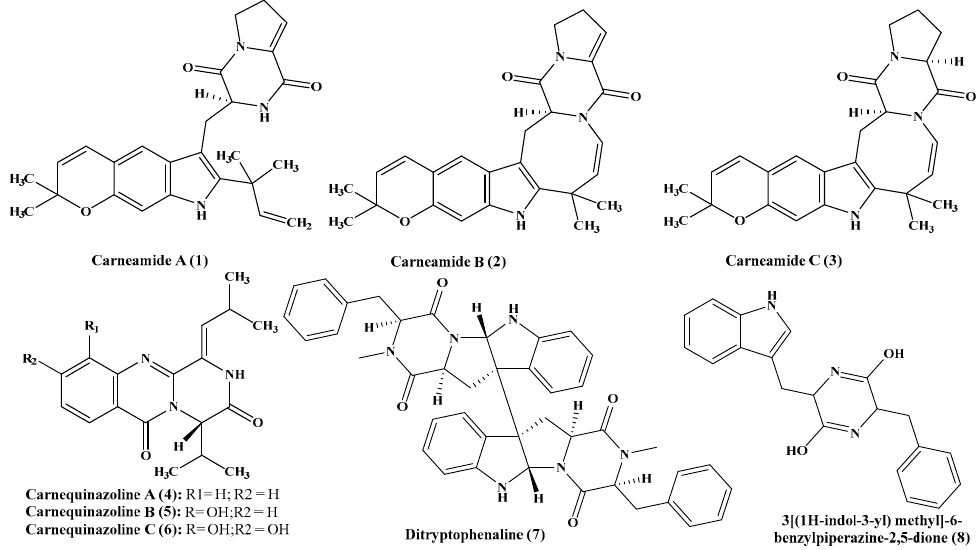
Figure 1. Alkaloids isolated from Aspergillus carneus and A. flavus.